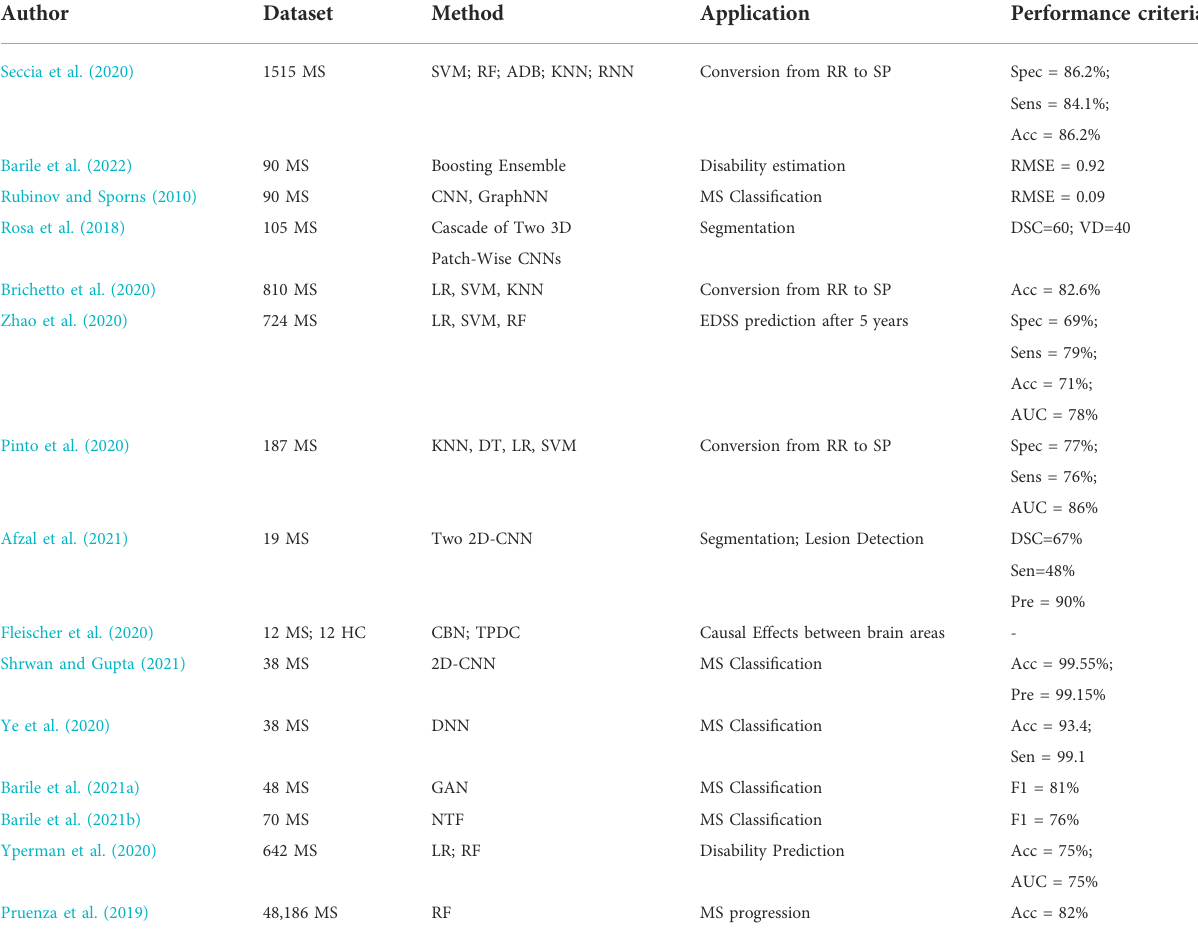
TABLE 1 Overview of the most relevant studies in the fi eld of MS analysis from the literature using MRI